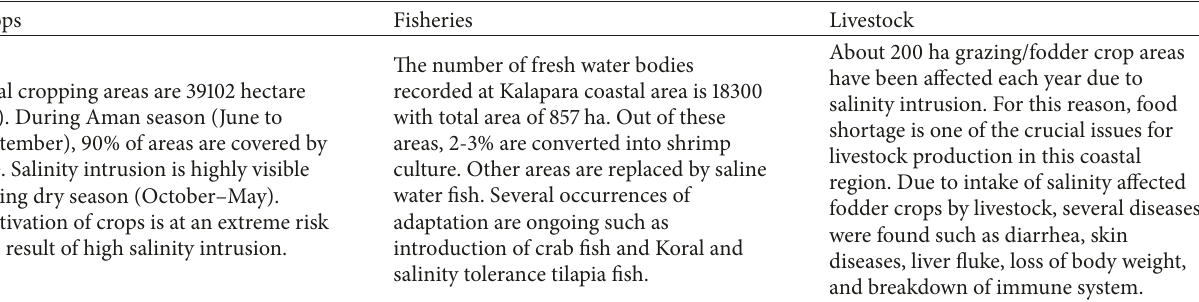
Potassium (K + ), mg/l